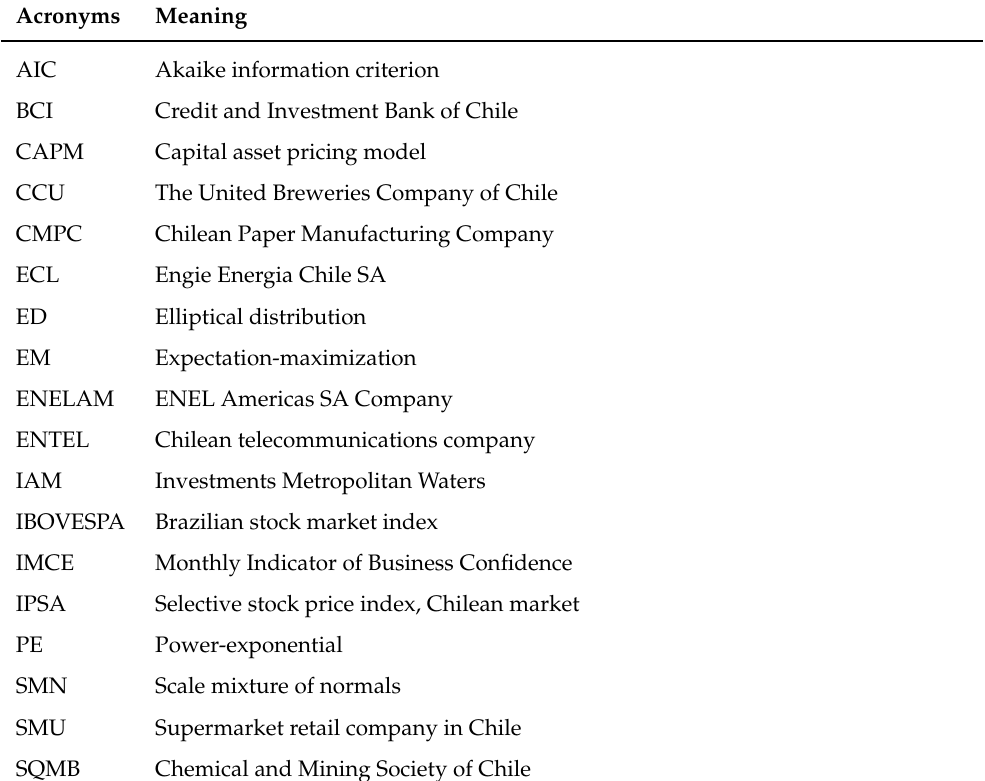
Table A1. Acronyms used in the present